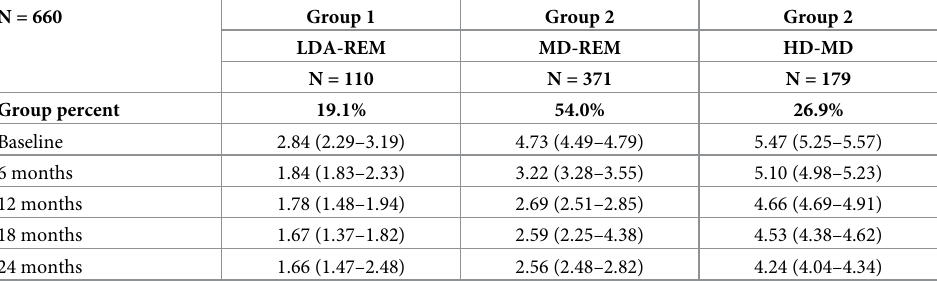
Table 2. The mean (95% CI) DAS28-ESR values at each time point for trajectory classes in patients with early RA. N = 660 Group 1 Group 2 Group 2 LDA-REM MD-REM HD-MD N = 110 Group